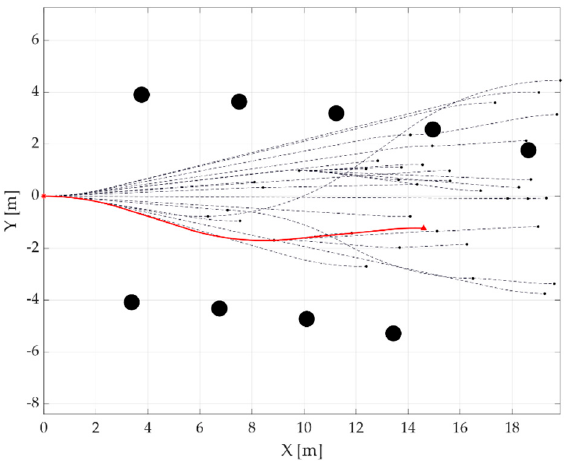
Figure 10. Generated path (solid, red) and search tree expansion (dashed, black) for a right turn, with obstacles (black, dots), starting vehicle position (red asterisk) and goal point (red triangle).